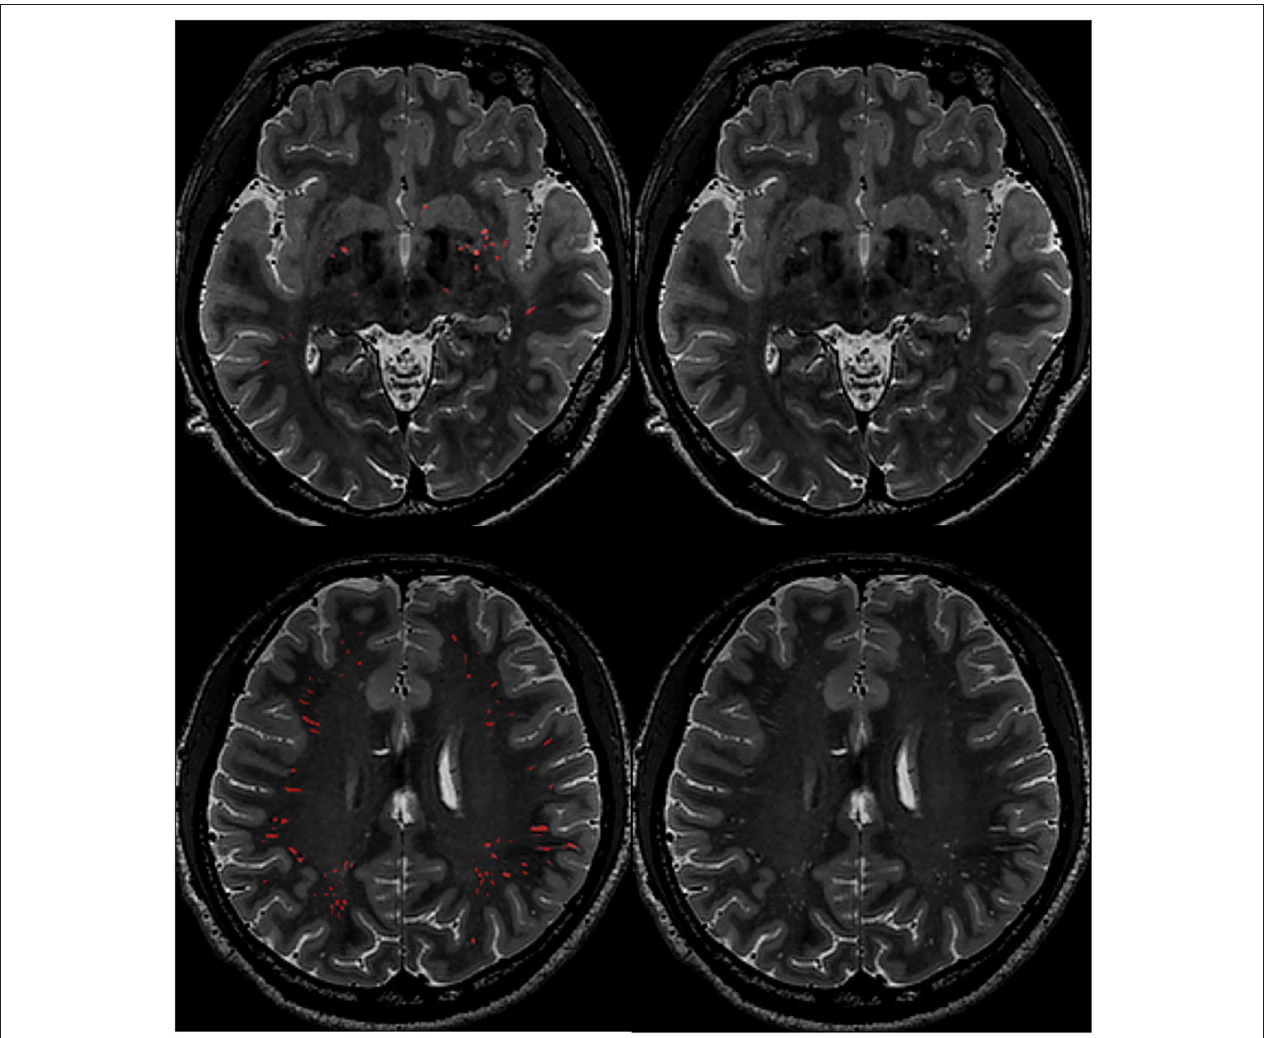
FIGURE 1 | Example images of PVS segmentation results. First row: PVS in the basal ganglia region; Second row: PVS in the deep white matter region. Red color indicates segmented